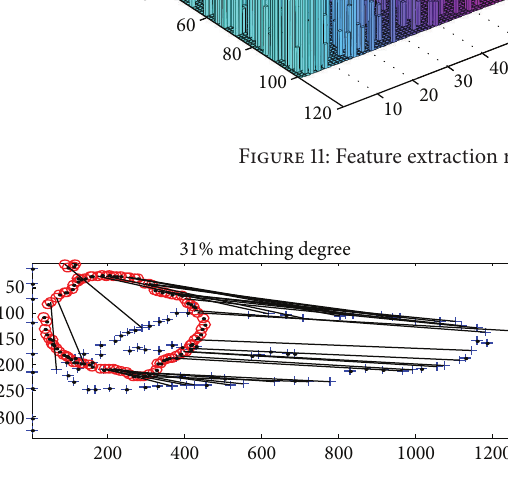
Figure 12: The final matching results.